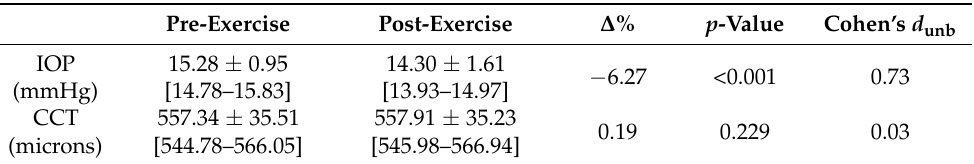
Table 2. Data comparison between the pre- and post-exercise intraocular pressure values in the study participants ( n = 49).